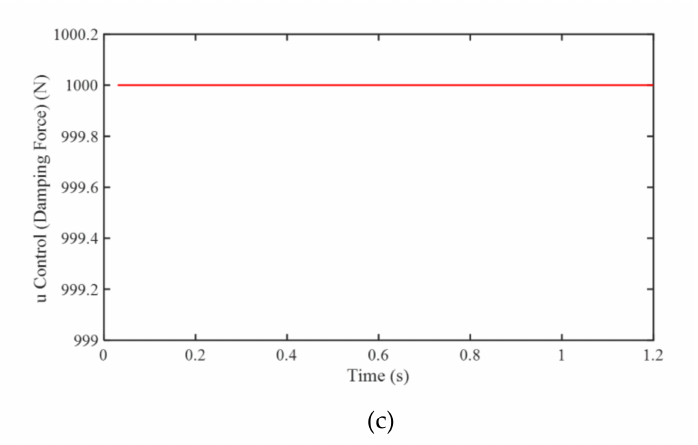
Figure 7. Damping force control: ( a ) proposed controller, ( b ) Compared Controller 1, ( c ) Compared Controller 2.